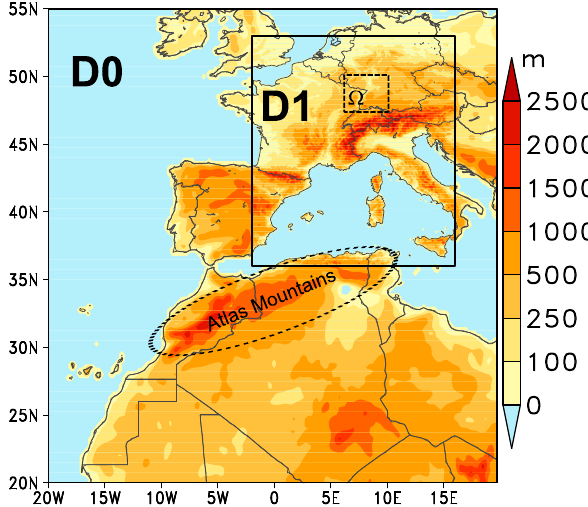
Fig. 2. Terrain height within the model domains D0 and